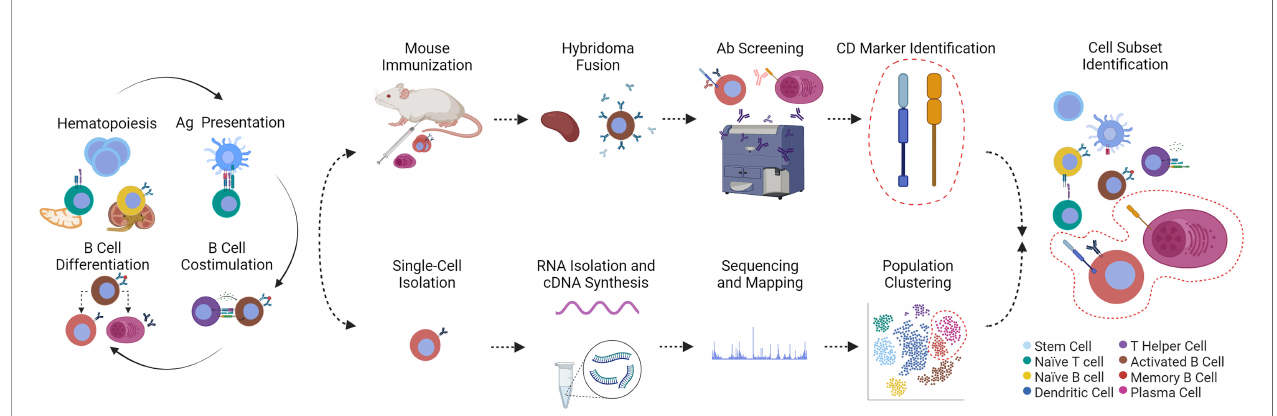
FIGURE 1 | (Immuno)phenotyping and discovery of fi sh leukocyte subsets via hybridoma technology or scRNA-seq technology are presented in chronological order from left to right. (Hematopoiesis) All leukocytes arise from hematopoietic stem cells in the thymus or kidney of fi shes. (Ag Presentation) Following activation and co- stimulation by antigen (Ag)-presenting cells, these mature lymphocytes are themselves precursors for differentiated T helper cells that activate B cells (B Cell Costimulation). (B Cell Differentiation) B cells then follow at least two fates into memory B or plasma cells. Immune responses therefore generate a plethora of immune cell subsets. The cells involved can be identi fi ed by hybridoma technology or scRNA-seq. (Top row, from left to right) As pioneered by Köhler et al. (18), unidenti fi ed immune cell subsets can be used as immunogen for laboratory animal immunizations; antibody-secreting cells from splenic tissue can be fused to immortalized myeloma cells. The resulting “ hybridomas ” produce monoclonal antibodies that are screened for reactivity to fi sh leukocytes. Reactive antibodies are used to identify the bound cluster of differentiation marker (CD marker) (19) that are then associated with a speci fi c leukocyte population. (Bottom row, from left to right) Alternatively, thousands of single cells are isolated, from which total RNA is reverse-transcribed, the complementary DNA sequenced and mapped to transcriptomes for comprehensive clustering of a heterogeneous population of cells based on hundreds of shared transcripts. To achieve the same result with traditional hybridoma technology would require isolation of hundreds of monoclonal antibodies and their corresponding (surface) markers. The cytoplasm of cells presented in this fi gure are color-coded based on the legend on the bottom right. The phenotyping and identi fi cation of memory B and plasma cells is shown as an example. Created with